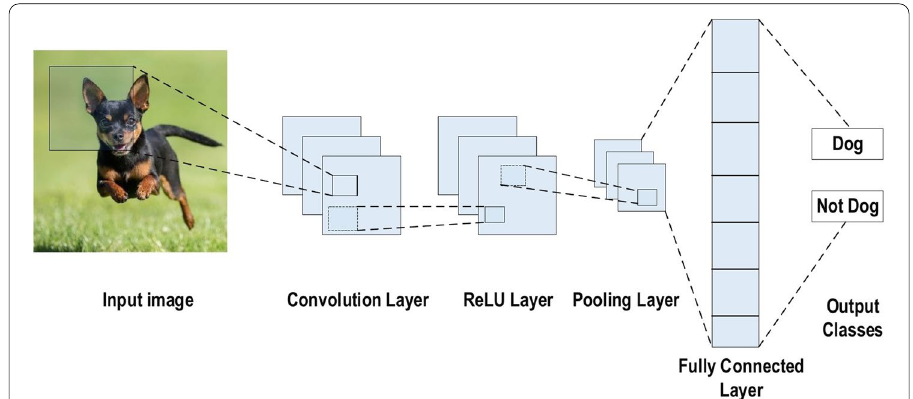
Fig. 7 An example of CNN architecture for image